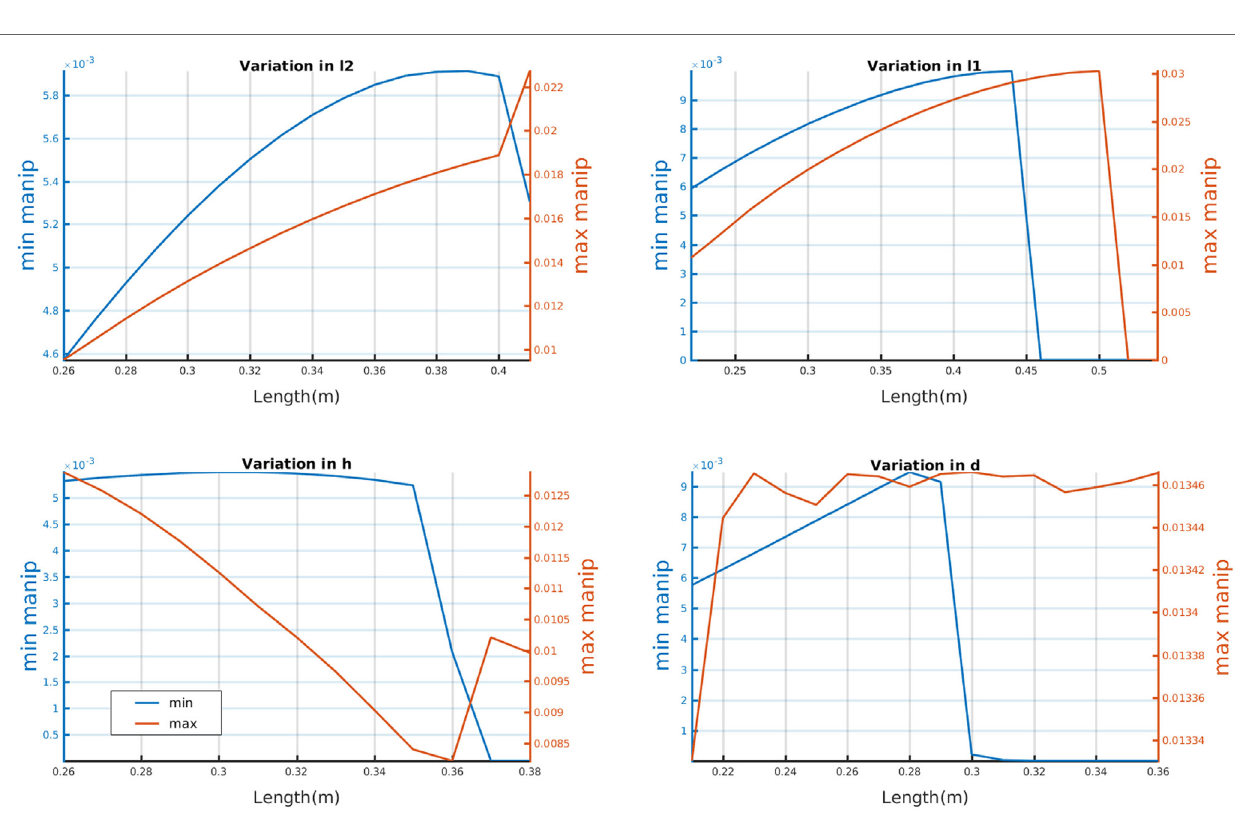
FigUre 8 | Variation of the manipulability for the considered task when the parameters of the simplified human model are varied, the parameters are varied one at a time keeping others constant. The maximum and minimum manipulability are shown in the right and the left vertical axis.